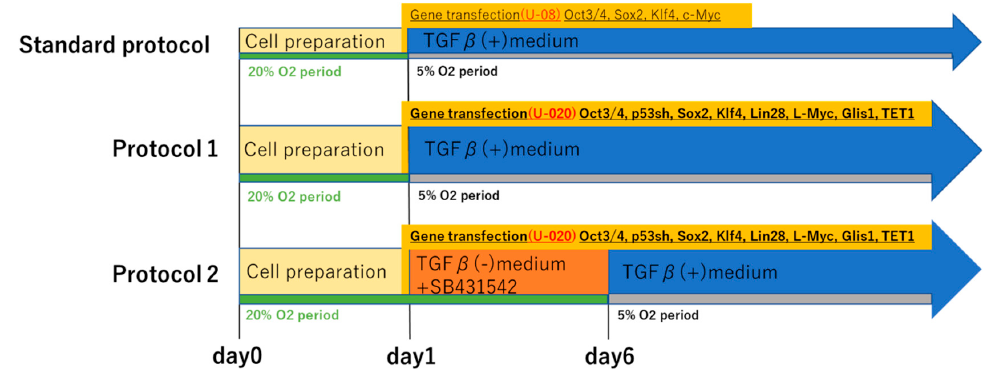
Figure 2. Protocols used for iPS cell reprogramming. Reprogramming protocols for iPS cell differentiation. Top indicates the standard protocol. This follows the protocol published by Center for iPS cell Research and application, Kyoto University. Protocol 1 (middle) and protocol 2 (bottom) are the novel protocol developed in this study. SB431542 is a selective inhibitor of the transforming growth factor beta (TGF- β ) type I receptor activin receptor-like kinase ALK5. “TGF- β ( + ) medium” indicates that TGF- β was included in the reprogramming medium, and “TGF- β ( − ) medium + SB431542” indicates that the reprogramming medium contained SB431542 but did not include TGF- β . Day 1 was defined as the date of gene transfer. “20% O 2 period” indicates that cells are incubated in O 2 20%, and “5% O 2 period” indicates that cells are incubated in O 2 5%. Each “U-08” or “U-020” indicates the transfection program for the Lonza nucleofector transfection system. “Oct3/4, Sox2, Klf4, c-Myc” or “Oct3/4, p53sh, Sox2, Klf4, Lin28, L-Myc, Glis1, and TET1” are transfected genes in episomal vectors. p53sh indicates short hairpin p53.